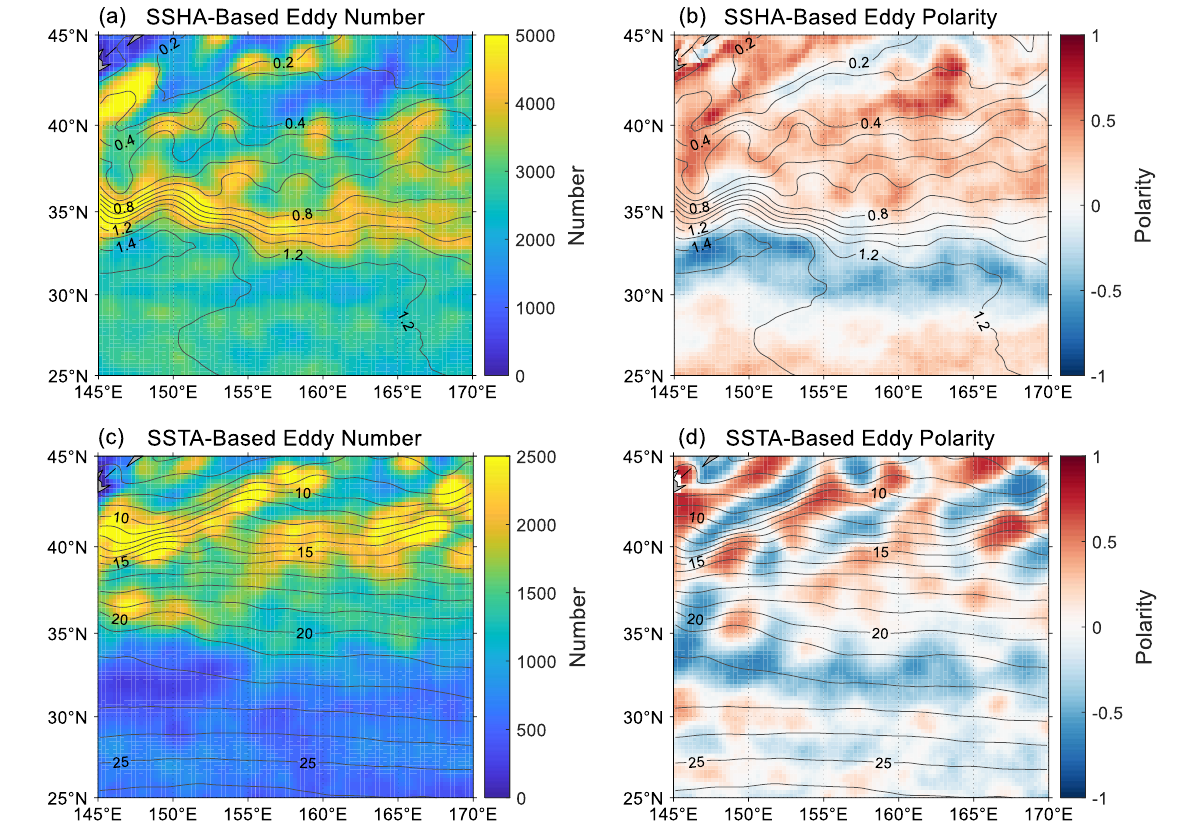
Figure 9. The maps of eddy number and polarity distribution from SSHA-based ( a , b ) and SSTA-based ( c , d ) eddy trajectories with lifetime ≥ 30 days. Contours in panel a and b are the climatological mean absolute dynamic topography ADT (unit: m); contours in panel c and b are the climatological mean SST (unit: °C).